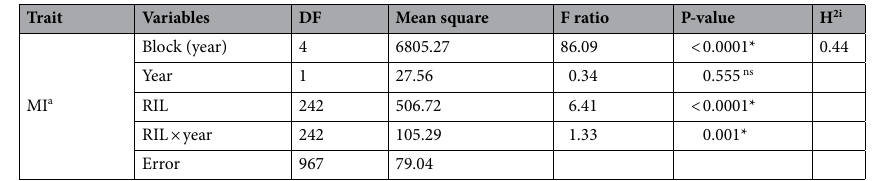
Table 2. Analysis of variance and heritability for MI trait for the IGC119 × Harari RIL population across 2 years. Block [year] indicates the nested effect of the Blocks within each year. a MI maturity index, i Broad sense heritability, * significant at P < 0.01; ns non-significant.